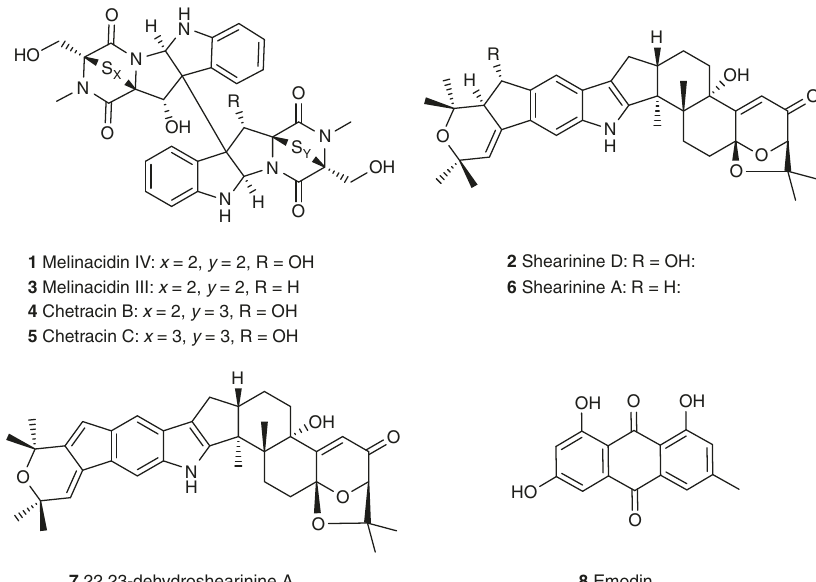
Fig. 3 Chemical structures of the major metabolites produced by Escovopsis strains